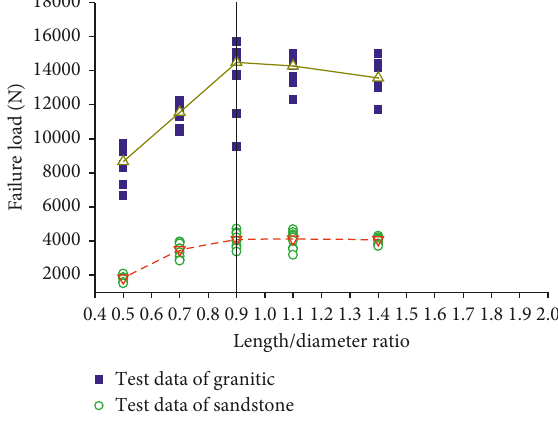
Figure 13: The results of the failure load with the length/diameter ratio from the laboratory